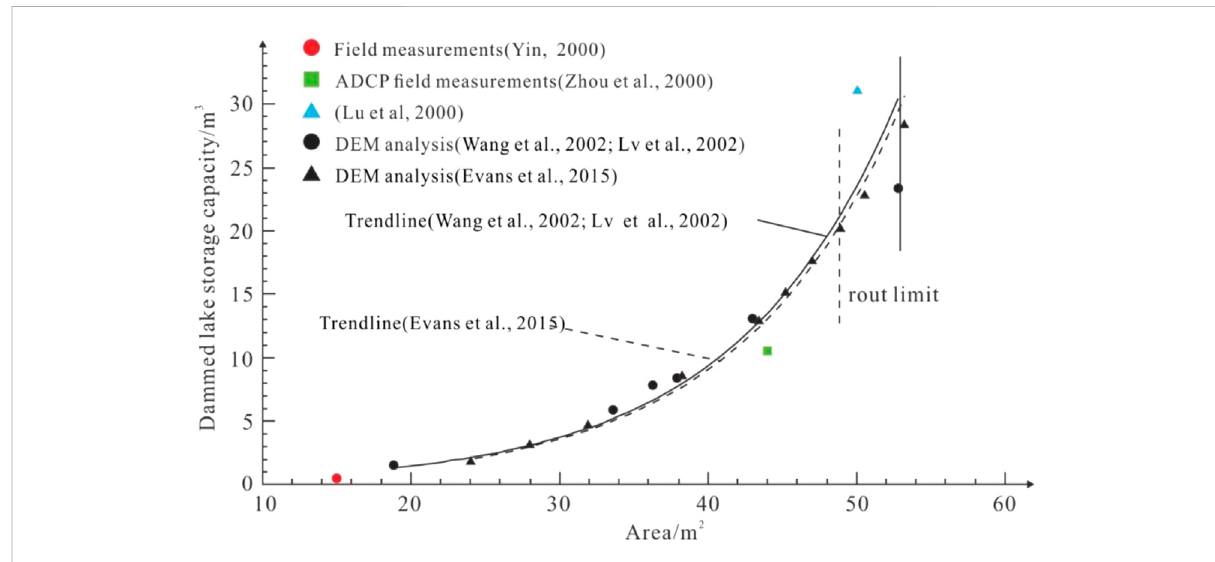
FIGURE 10 Comparison of the area and volume of the Yigong dammed